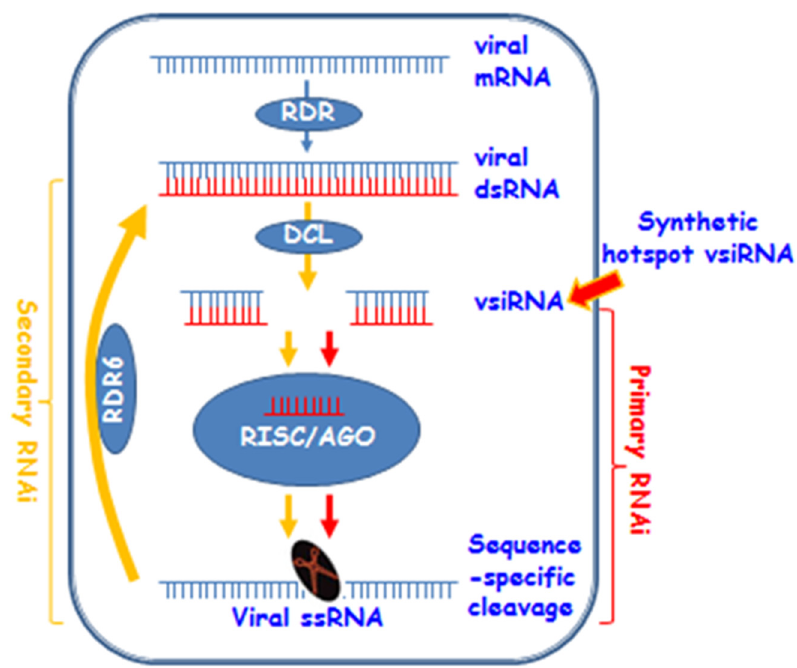
Figure 7. A model for synthetic hotspot vsiRNA-mediated antiviral RNAi. Viral RNA (mRNA) can be converted into dsRNA by plant RDRs such as RDR6. Then dsRNAs are diced into 21–24 nt vsiRNA by DCLs. At this stage, synthetic hotspot vsiRNA could enter the RNAi pathway. Subsequently, the guide strand of vsiRNA and AGOs are incorporated into the RISC. The RICS targets the viral ssRNA (or mRNA transcribed from viral genome) for sequence-specific cleavage to cause the primary RNAi effect. Primary RNAi can be amplified via RDR6 to trigger the secondary RNAi to increase viral defence in plants. It should be noted that this model does not exclude other possible mechanisms underpinning how vsiRNA might confer plant resistance against virus infection. For instance, vsiRNA could block virus entry to or inhibit viral genome replication in host cells.